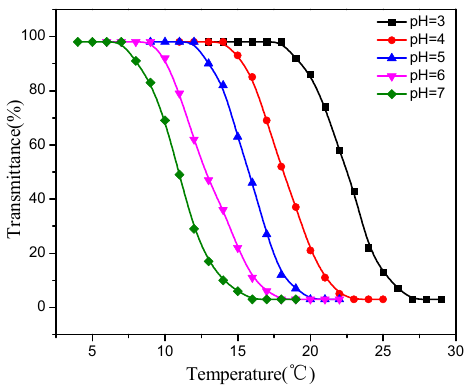
Figure 9. The curves of transmittance versus temperature of HPNPAMs. Aqueous solution with different pH values. Solution concentration: 3 mg·mL − 1 ; heating rate: 0.1 °C ·min − 1 .